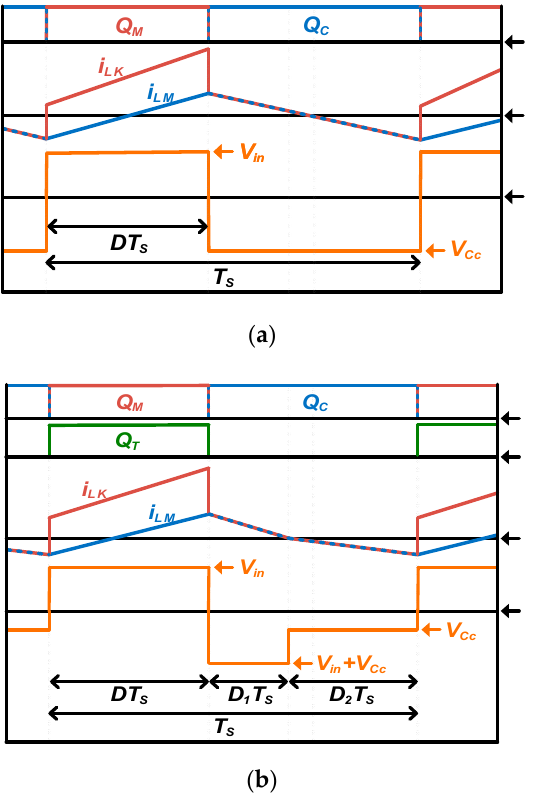
Figure 3. Simplified transformer waveform ( a ) active ‐ clamp forward converter; ( b ) three ‐ switch active ‐ clamp forward converter.